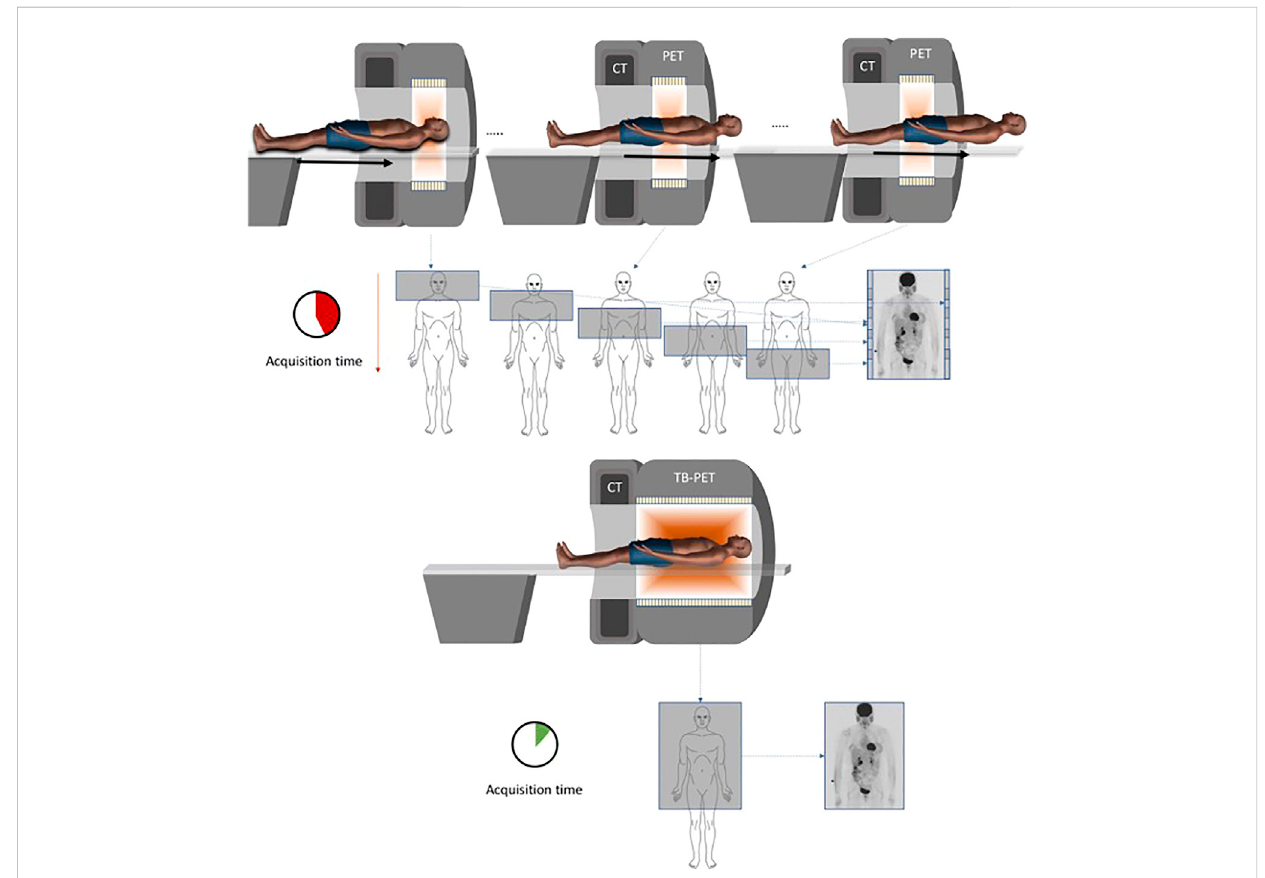
FIGURE 10 Top: Typical PET system with multiple scans to reconstruct a whole body image. Bottom: Total body PET system with a single scan to reconstruct a whole body image. Reproduced under CC-BY license 4.0 from